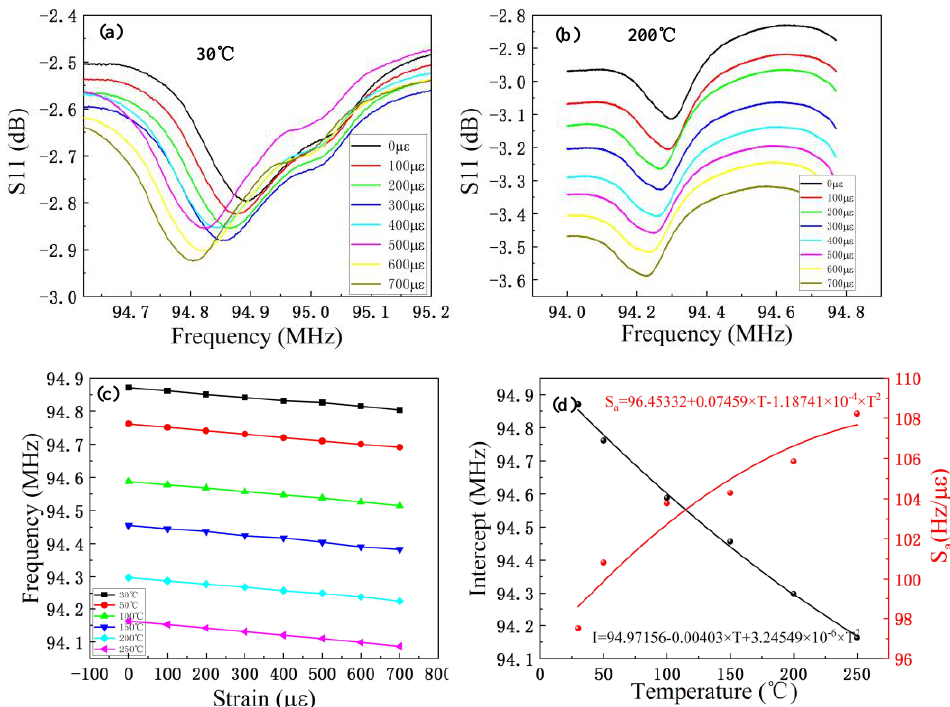
Figure 7. Strain test results of strain-sensing unit under different temperature environments. ( a ) Strain response curve of the strain sensor at 30 ◦ C for 0–700 µ E . ( b ) Strain response curve of the strain sensor at 200 ◦ C for 0–700 µ E . ( c ) The relationship between resonant frequency and strain of the strain-sensing unit under different strains at 30~250 ◦ C. ( d ) Polynomial fitting of the slope and intercept of the curve of resonance frequency variation with strain at different temperatures.